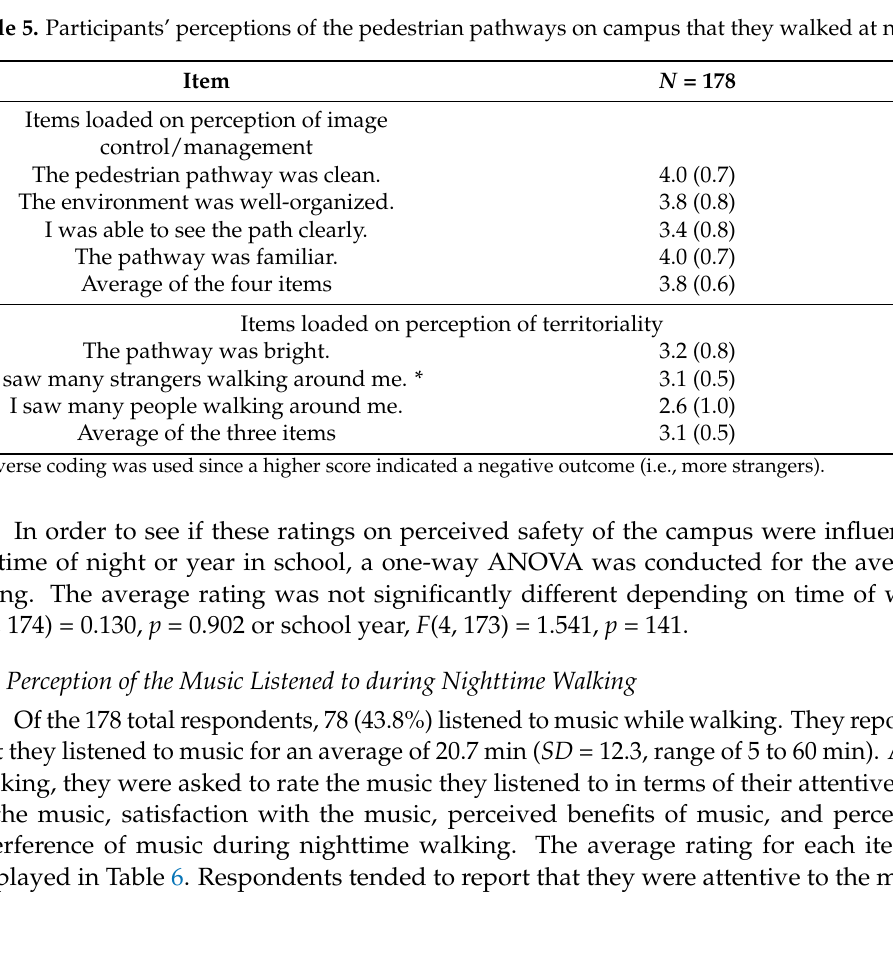
Component 1 2 0.835 0.043 0.715 0.005 0.558